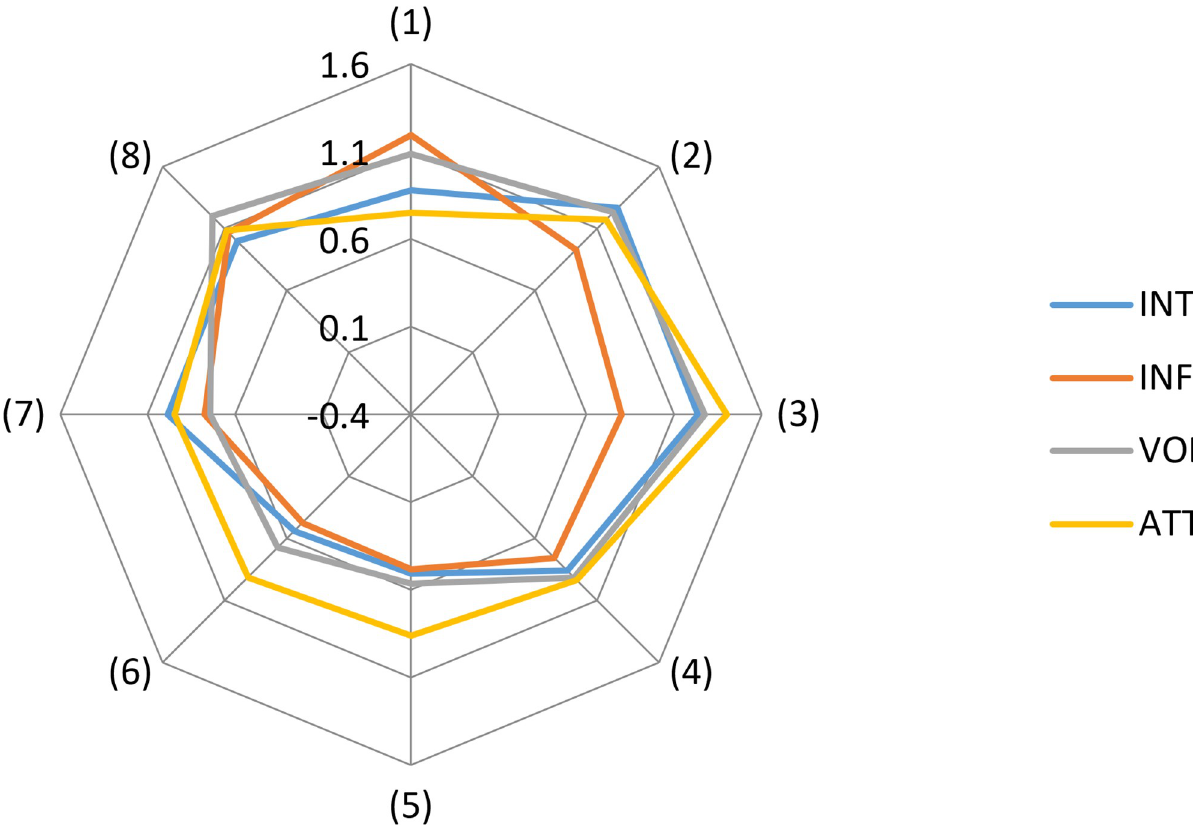
Fig 4. Standard deviation of the four variables for all stakeholder